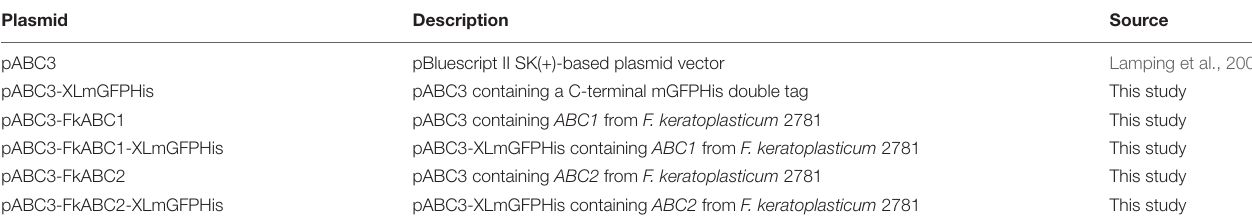
TABLE 2 | Plasmids used in this study.